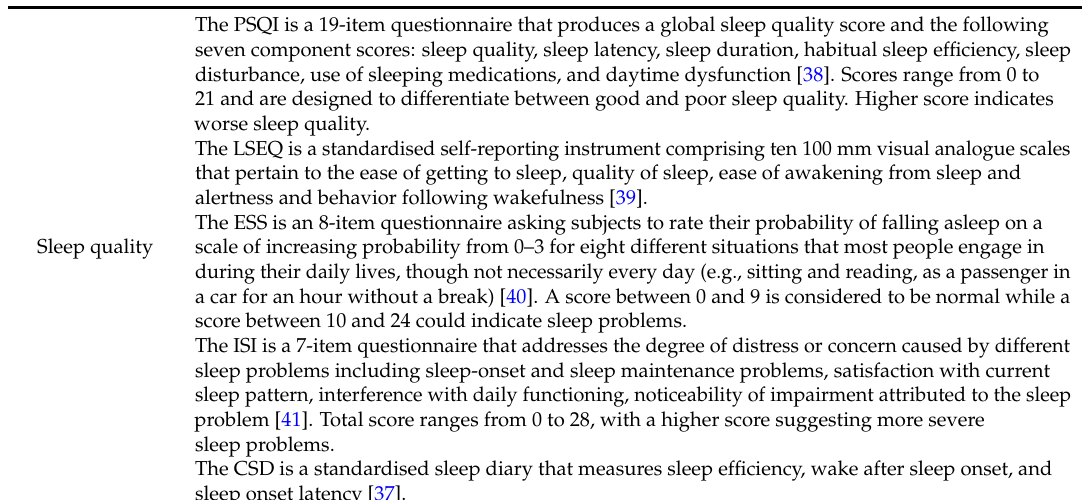
Table A2. Treatment